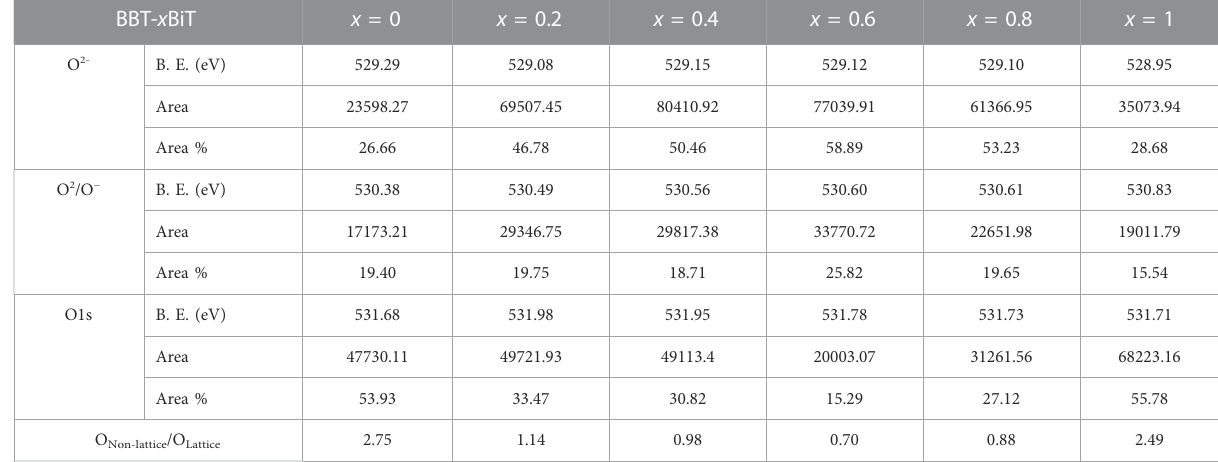
TABLE 1 Bind Energy, Peak Area and its Area percentage content of oxygen peaks, and ratio of O Non-lattice /O Lattice for all